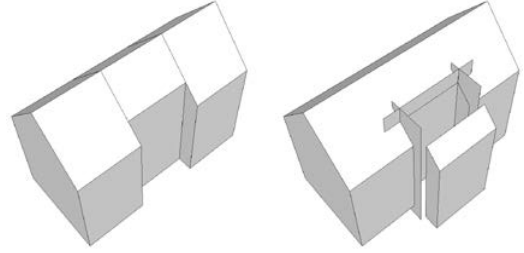
Figure 10. Two approaches to model a gable roof with an intrusion.